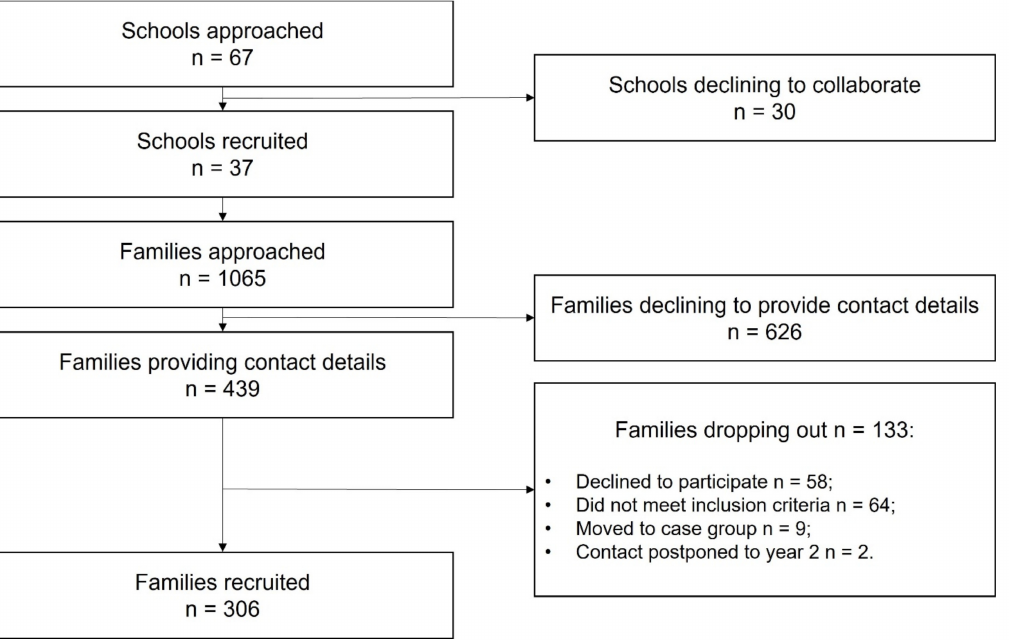
Figure 2. Flow chart describing the progress in the recruitment of controls at the end of the Year